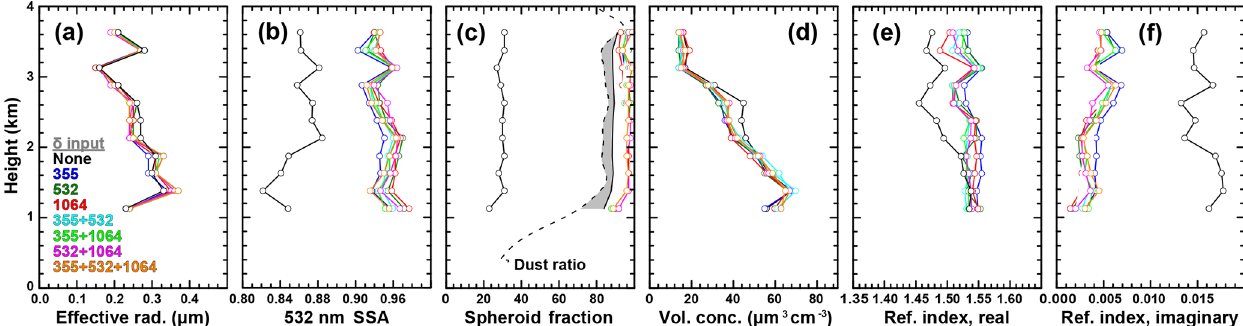
Figure 3. Inversion results of (a) effective radius, (b) 532nm SSA, (c) spheroid fraction, (d) volume concentration, and the (e) real and (f) imaginary part of the refractive index for eight inversion runs with varying depolarization-ratio input (colours; see also Table 2), using the input data presented in Fig. 2. The dashed and solid lines in the plot of the non-spherical fraction (c) refer to the contribution of dust to the 532nm backscatter coefficient that can be obtained according to the procedures described by Tesche et al. (2009b) (dust, two-component mixture) and Mamouri and Ansmann (2017) (fine and coarse dust, three-component mixture), respectively. The grey area between the two lines marks the likely range of the dust ratio as defined by the two approaches.